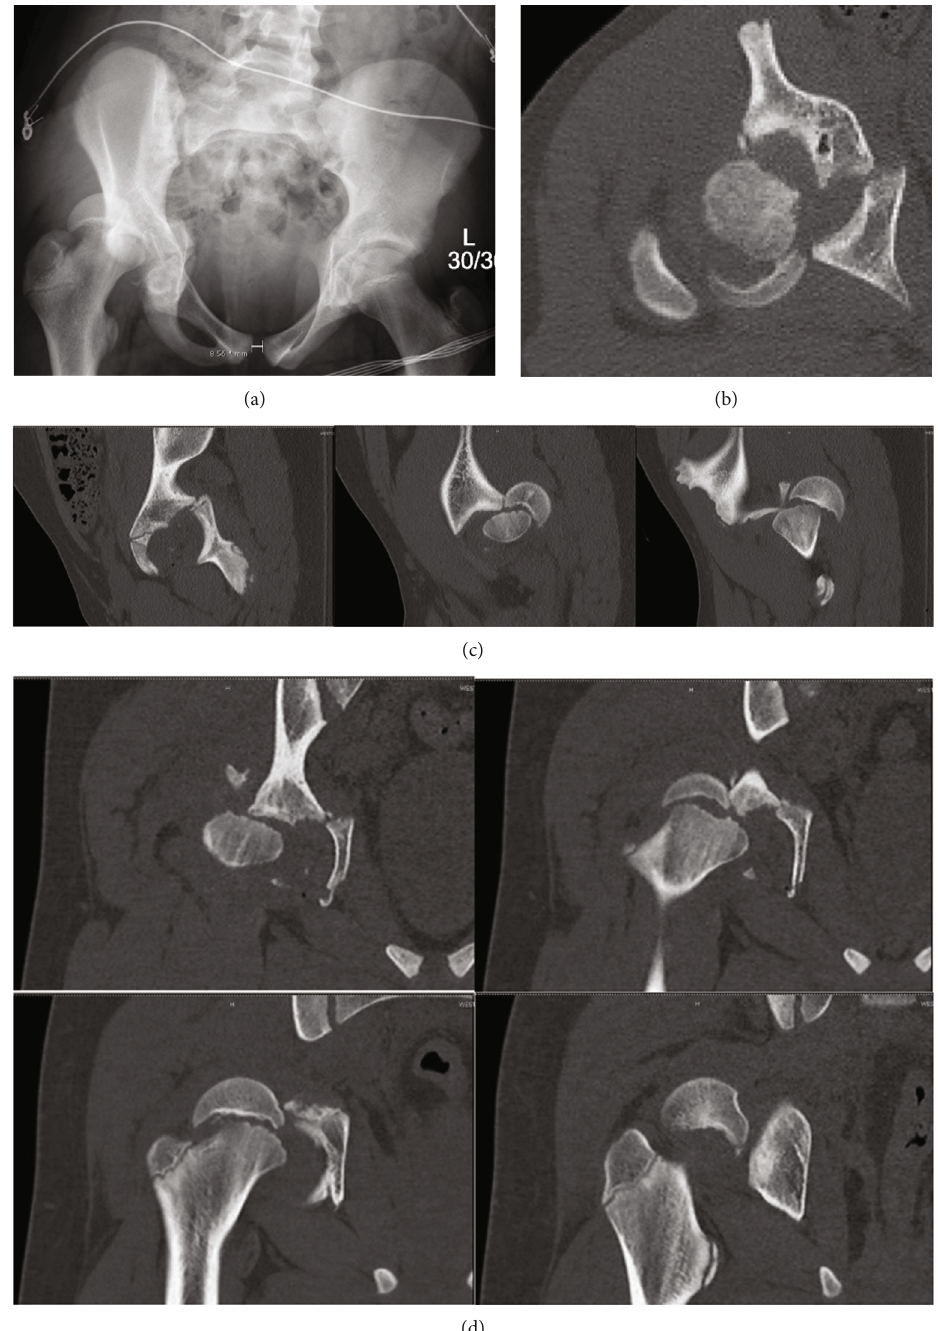
Figure 1: (a) Injury radiographs and selected (b) axial, ((c) 1 – 3) sagittal, and ((d), 1 – 4) coronal computed tomography cuts demonstrating displaced right capital femoral epiphysis and posterior fracture-dislocation of right hip with posterior column acetabular